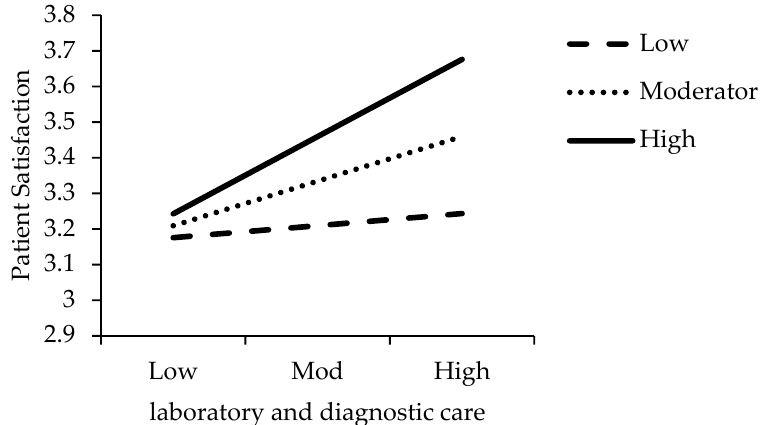
Figure 2. Interactive effect of the laboratory and diagnostic care (LDC) and physician’s behavior (PB) on patient satisfaction.